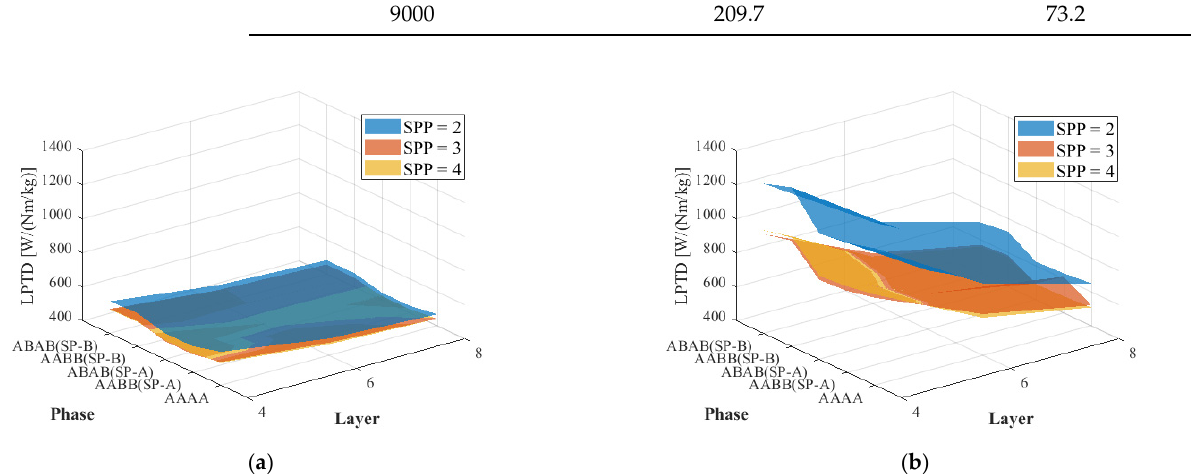
Figure 16. Comparison of LPTD as a function of phase arrangement and conductor layer for three SPP values: ( a ) 98 kW at 3000 rpm; ( b ) 98 kW at 9000 rpm.